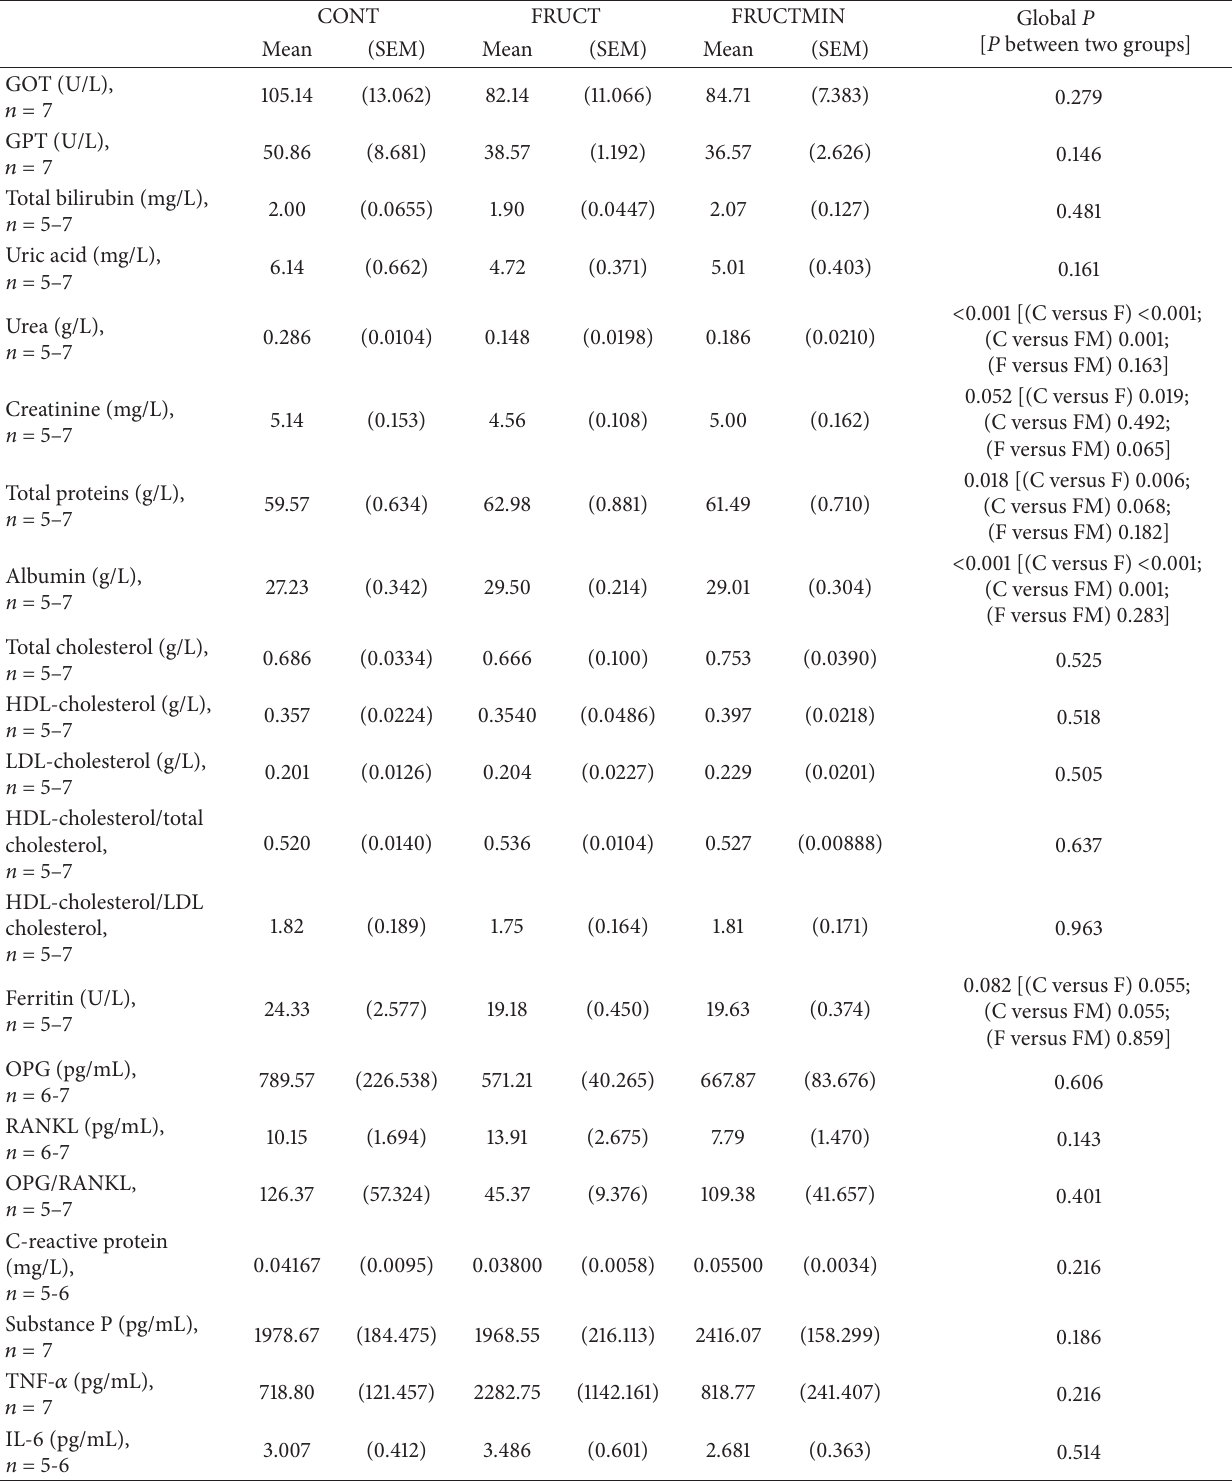
Table 2: Plasma biochemical and inflammatory marker levels, at the end of the dietary intervention. CONT FRUCT FRUCTMIN Global P